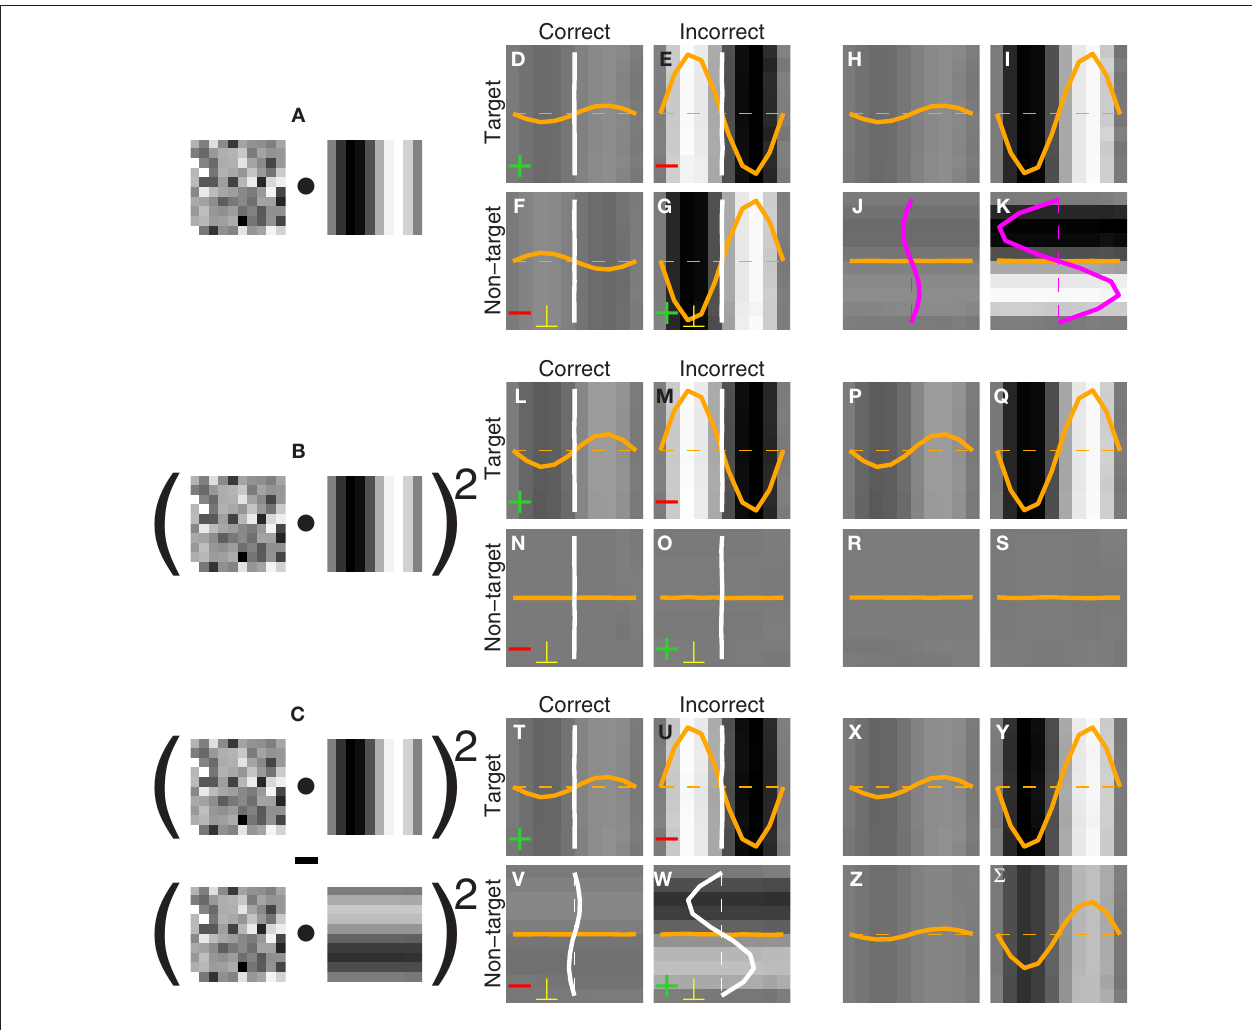
Figure 14 | Simulated perceptual filters. We tested three simple models, starting with linear template matching (A) . The model in (B) is the same as (A) , except the output of the matching operation is squared. (C) Is the same as (B) minus the output of a unit orthogonal to (B) with reduced gain. See Section 2.8